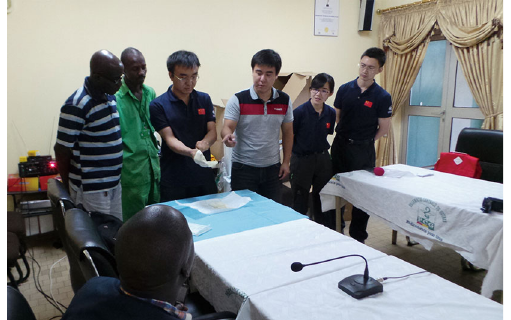
Figure 4. Photograph of Dr. George F. Gao (middle) with Dr. Abdul Kamara (left) and myself (right) during Dr. Gao ’ s second journey to Sierra